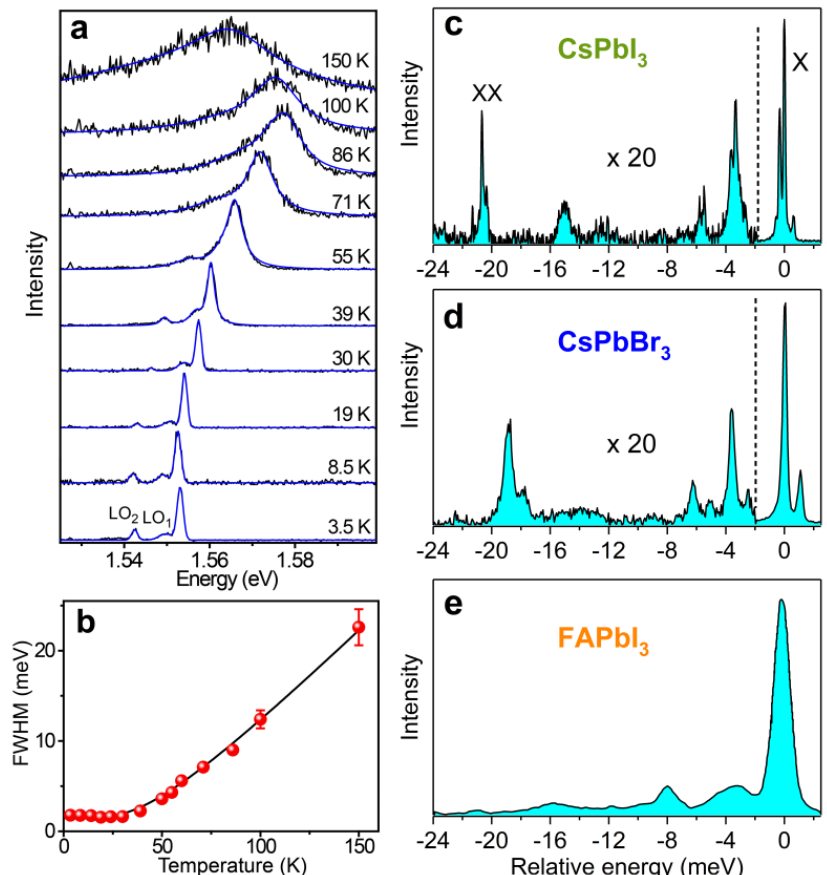
Figure 3. Exciton – phonon coupling. ( a ) Temperature dependence of the PL spectrum of a FAPbI 3 NC. The spectra are fitted with Gaussian profiles below 30 K and Lorentzian profiles at higher temperatures (blue curves). The spectrum shifts to the blue as the temperature is raised up to ~100 K. This typical behavior of perovskites is attributed to a lowering of the valence band maximum accompanying the lattice expansion [61]. At higher temperatures, non-monotonic shifts of the PL spectrum are usually assigned to phase transitions in the crystalline structures [43,45,55]. ( b ) Evolution of the ZPL line width (FWHM) with temperature for the same NC. The black curve is a fit with the expression of Γ(𝑇) , taking Γ 0 = 1.5 meV, 𝛾 𝑎𝑐 < 5 µeV K − 1 , Γ LO = 27 meV, E LO = 10.7 meV. ( c – e ) Three main LO phonon replicas are observed in the PL spectra of single perovskite NCs of various compositions: (c) CsPbI 3 , ( d ) CsPbBr 3 and ( e ) FAPbI 3 NCs. Note that the structure labeled XX in ( c ) is attributed